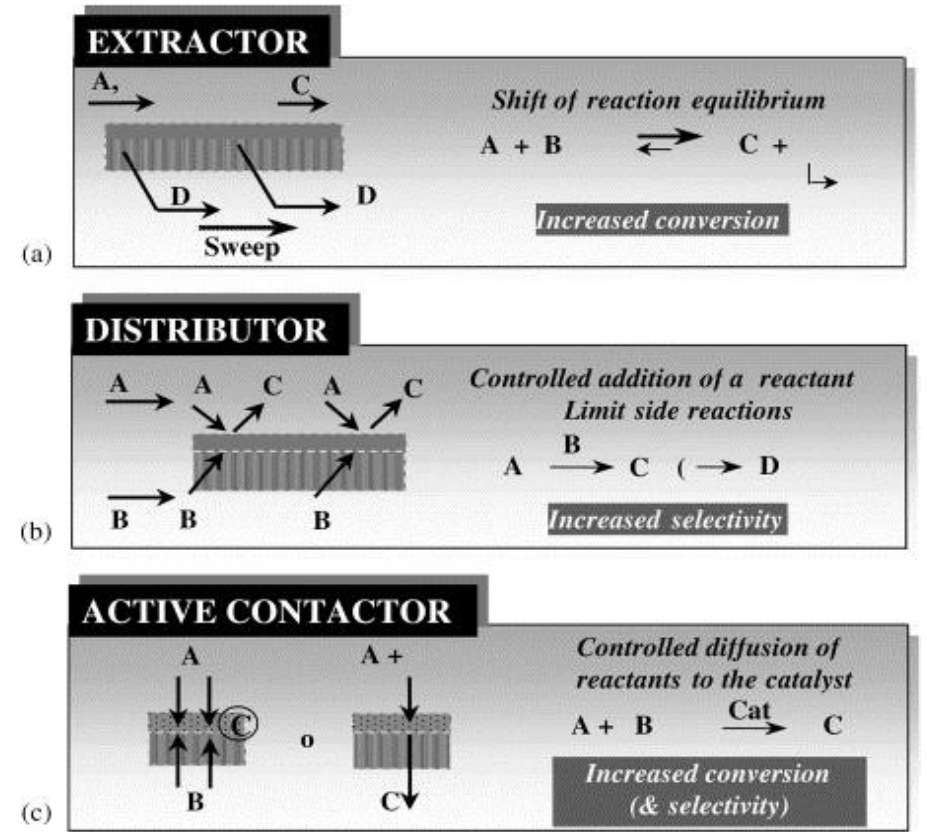
Figure 10. The three main membrane functions of the membrane reactors. Figure modified with permission of the authors of [153].